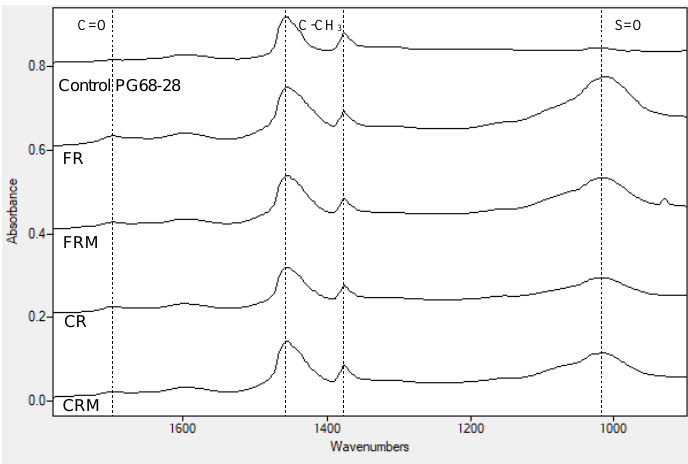
Figure 8. Compilation of FTIR spectra featuring C = O and S = O oxidation bands.